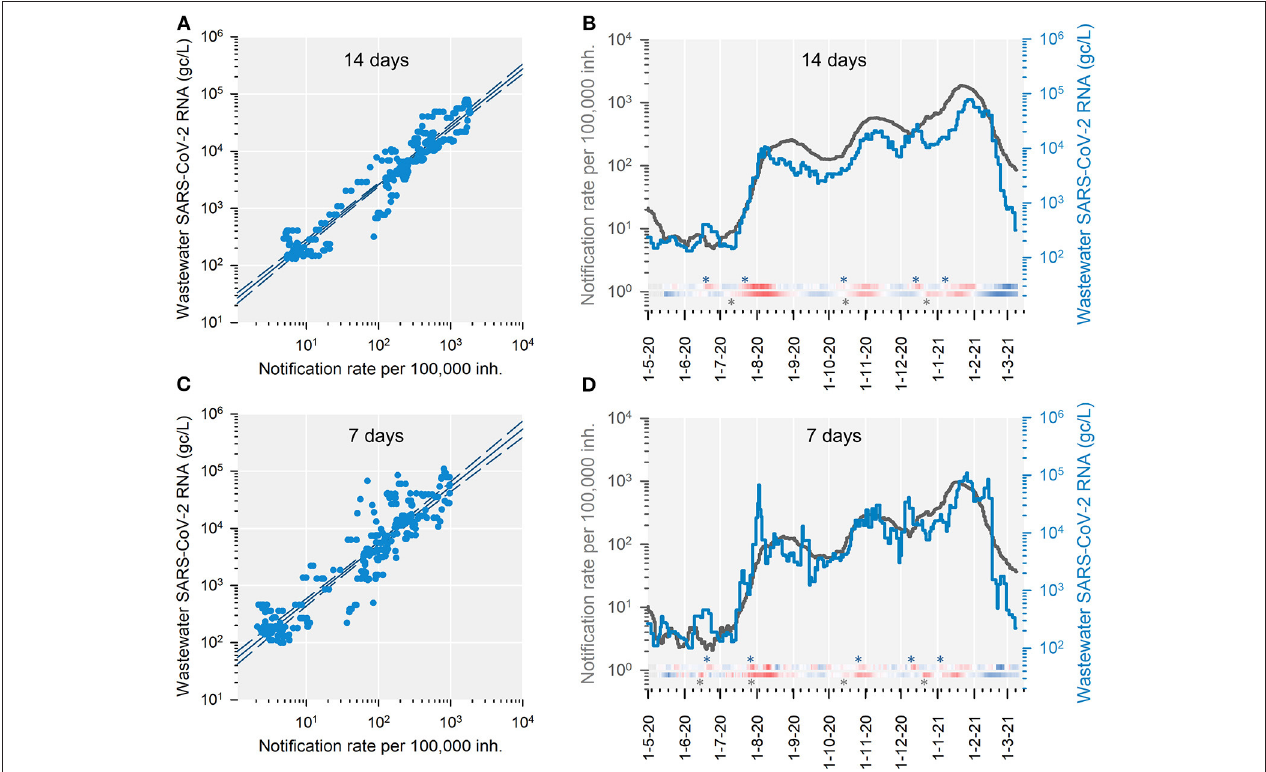
FIGURE 2 | SARS-CoV-2 wastewater signal and notification rates over 14-day or 7-day periods. Average log SARS-CoV-2 RNA concentrations in wastewater and cumulative case notification rates per 100,000 inhabitants are shown. These variables were calculated for each of 301 periods of 14 days, or 322 periods of 7 days, using a one-day shifted sliding window. (A) Least-squares log-log linear regression using 14-day periods. Equation for the linear regression line: y = 1.011 x + 1.393. Goodness of fit: r 2 = 0.925. The 99% confidence intervals are shown. (B) 14-day time series. The heat maps below the curves show the difference between consecutive periods for wastewater data (top) and notification rates (bottom). Asterisks indicate the first day in which a significant increase between two consecutive 14-day periods was detected. (C) Least-squares log-log linear regression using 7-day periods. Equation for the linear regression line: y = 1.009 x + 1.699. Goodness of fit: r 2 = 0.856. The 99% confidence intervals are shown. (D) 7-day time series. Heat maps and asterisks indicating the first day in which a significant increase between two consecutive 7-day periods was detected are shown.